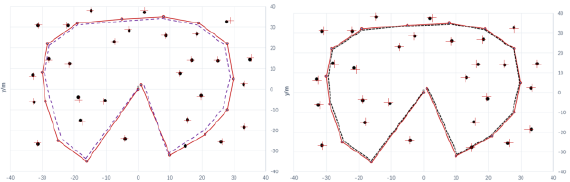
Figure 3: Estimate result of QRUKF Figure 4: Estimate result of QRUKF